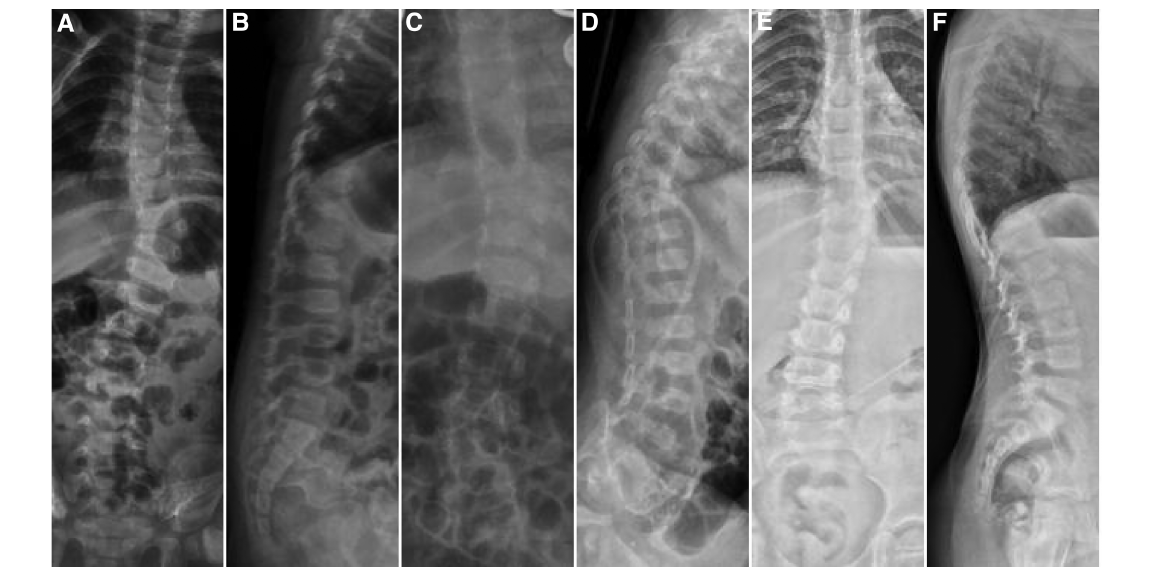
FIGURE 2 Case 14, female, 9 months old. Preoperative orthogonal ( A ) and lateral ( B ) x-rays showing the left hemivertebrae at T10. Intraoperative hemivertebra resection was performed via the posterior approach, and postoperative orthogonal ( C ) and lateral ( D ) x-rays are shown. At 3 years of follow-up, the orthogonal ( E ) and lateral ( F ) x-rays showed good correction of the coronal and sagittal